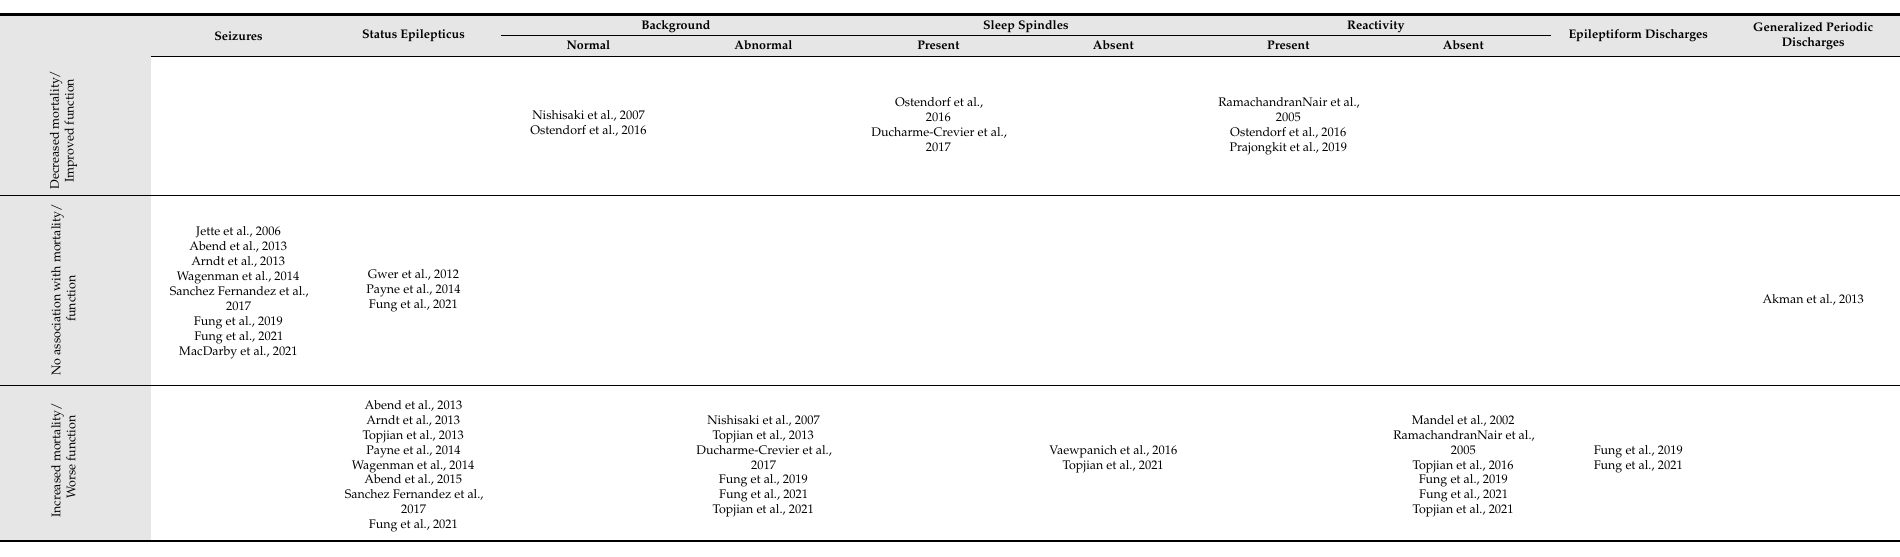
Table 1. EEG features and the association with clinical outcomes